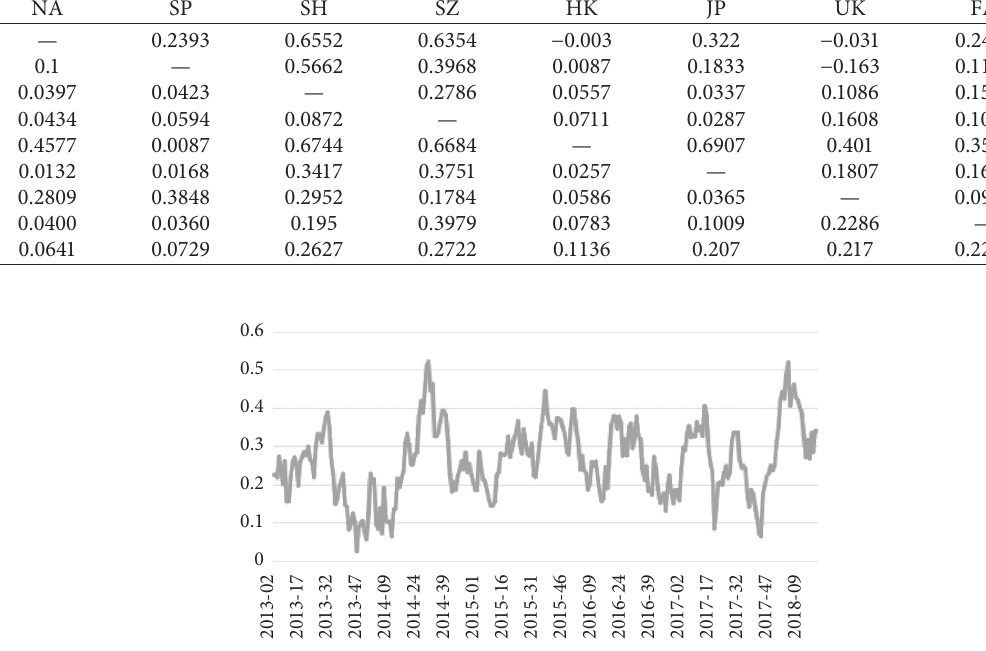
Figure 2: Correlation ρ between the S&P index and Shanghai Composite Index.